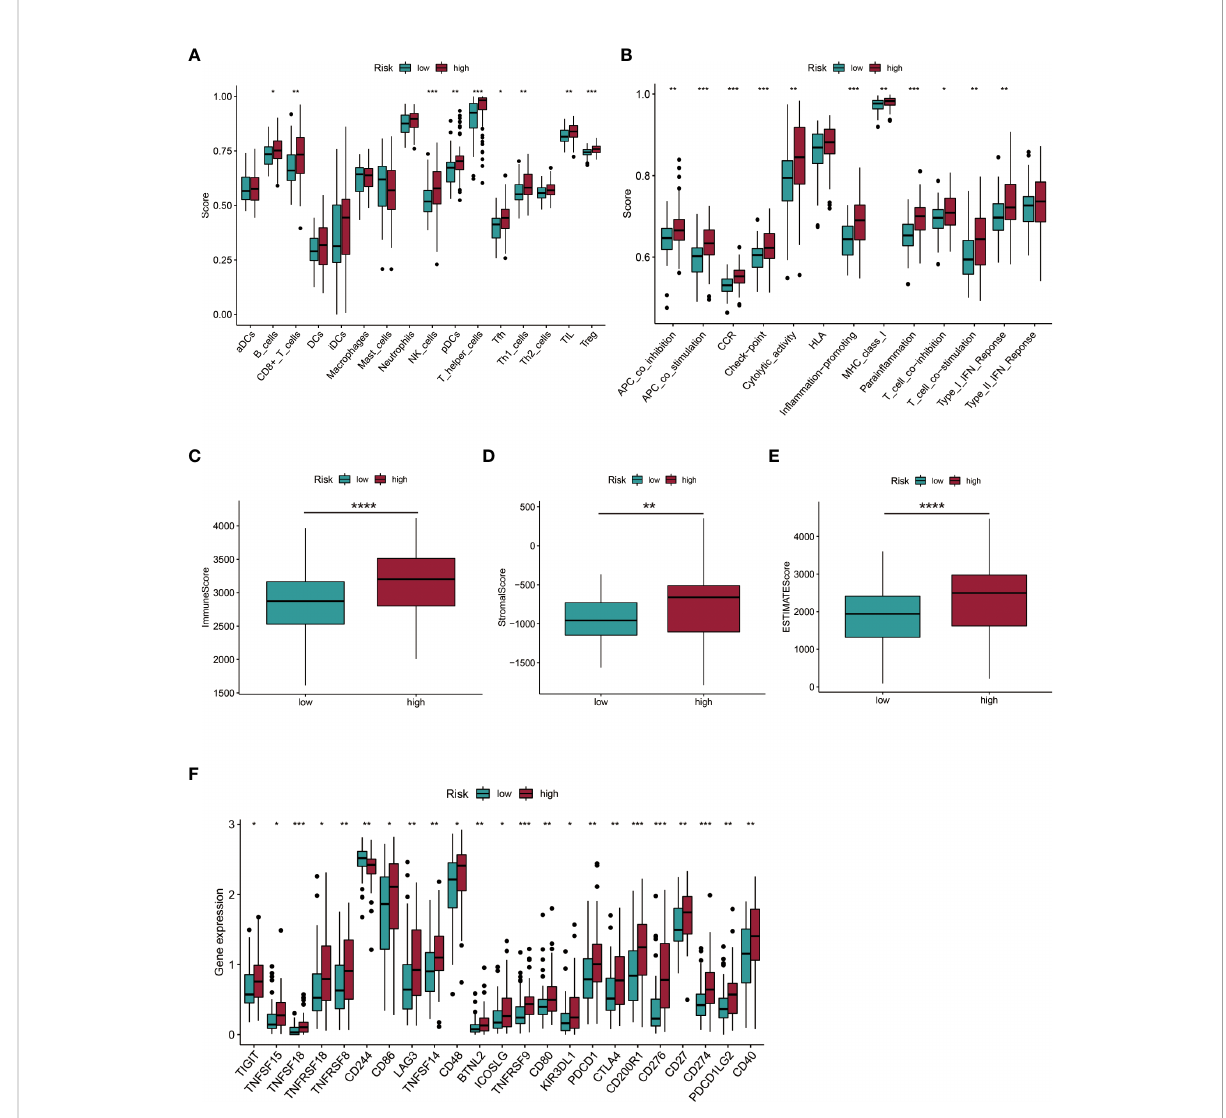
FIGURE 10 Investigation of immune cell in fi ltration and the tumor environment (TME). (A, B) Immune cell in fi ltration and immune-related function activation in the low- and high-risk group of AML patients. (C-E) Comparison of immune-related scores between low- and high-risk groups. (F) Twenty-three differentially expressed checkpoints between low- and high-risk groups. * P < 0.05; ** P < 0.01; *** P < 0.005; **** P <